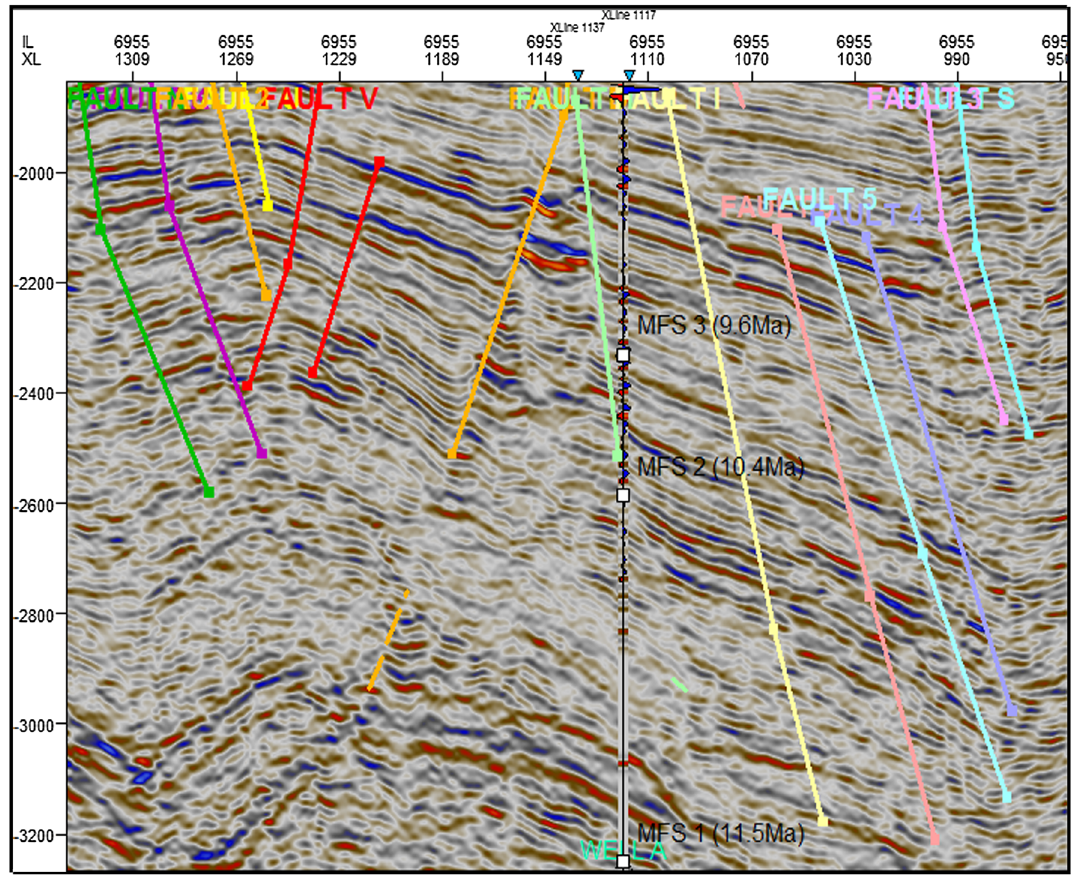
Fig. 7 Display of seismic-to-well tie using the generated synthetic seismogram and mapped structural